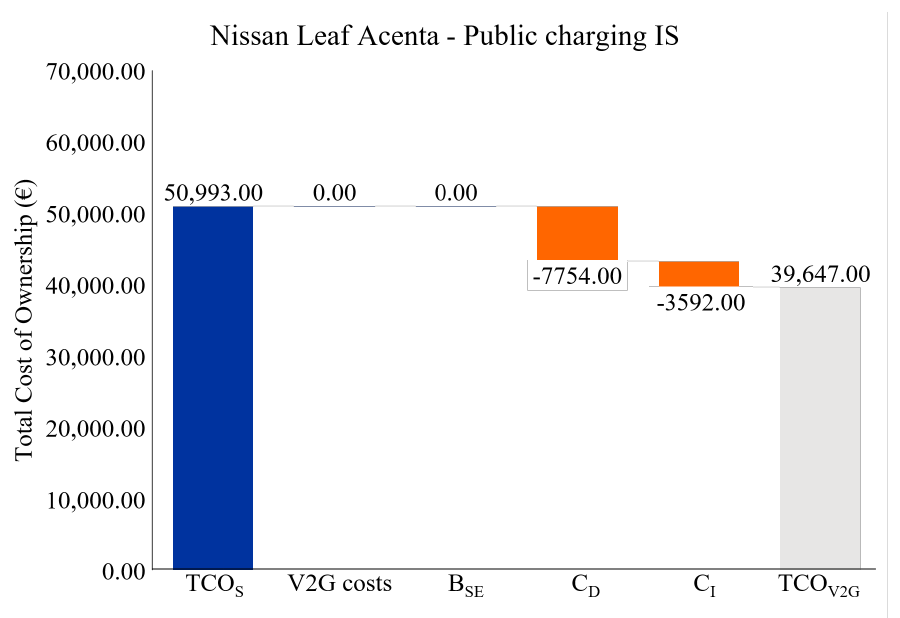
Figure 12. Standard and V2G TCO of a Nissan Leaf in a public charging case providing IS ( TCO S = Standard TCO, B SE = benefit of saved electricity costs from the grid, C D = direct com- pensation, C I = indirect compensation, TCO V 2 G = V2G TCO); source: own